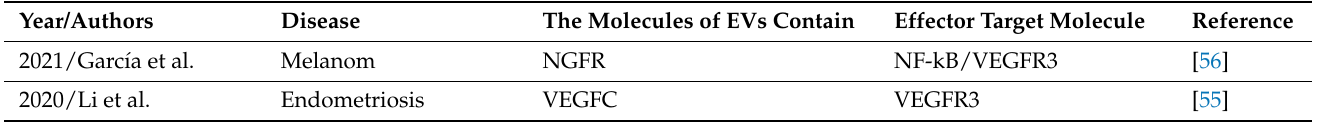
Table 2. Examples of molecules carried by EVs that promote lymphangiogenesis in various